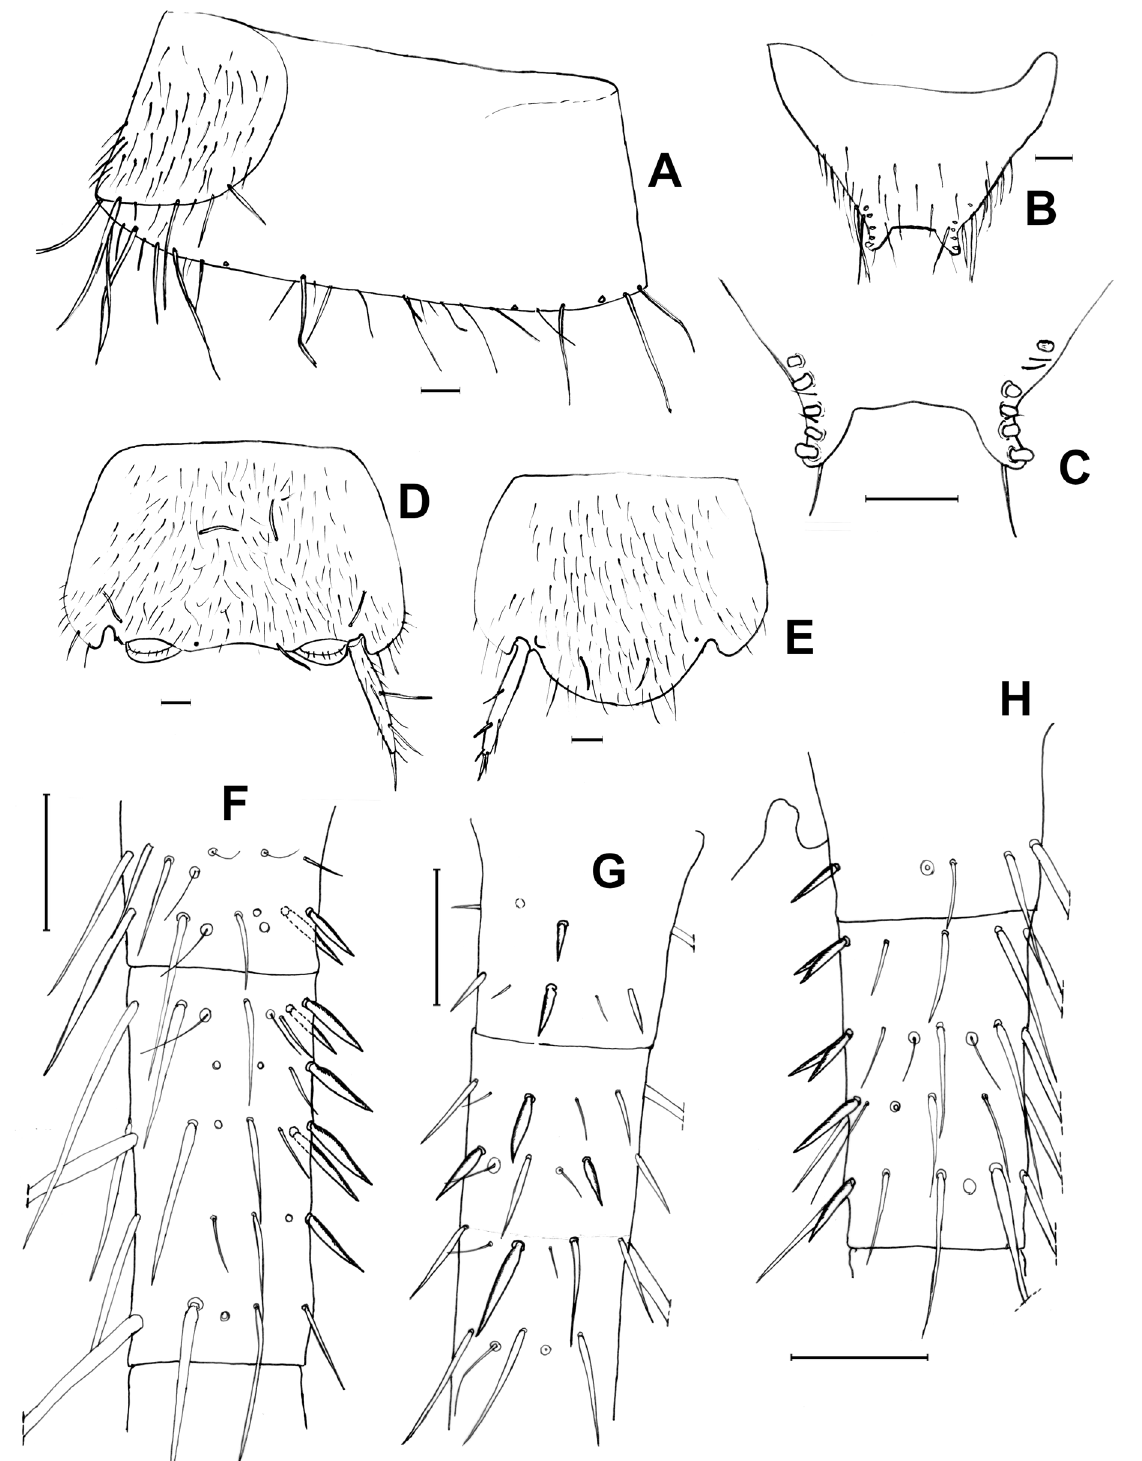
Fig. 8. Coletinia dextra Molero-Baltanás, Bach de Roca & Gaju-Ricart sp. nov. Holotype, ♂ (MNCN_ Ent 283557). A . Urotergite II. B . Urotergite X. C . Detail of the hind margin and posterolateral lobes and pegs of the urotergite X. D . Urosternite V. E . Urosternite VIII. F . Left cercus. G . Paracercus. H . Right cercus. All terminal filaments in dorsal view. Scale bars = 0.1